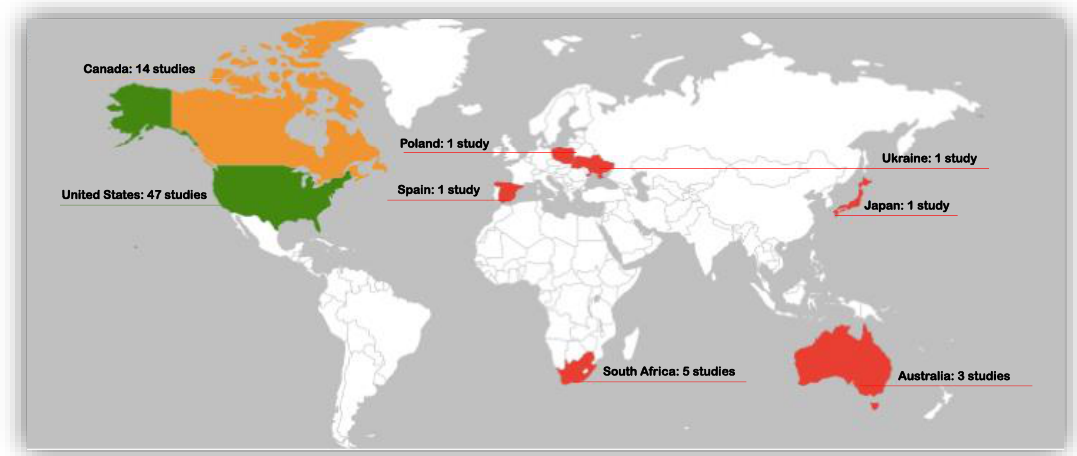
Figure 4. A global representation of the prevention and management intervention studies by countries.